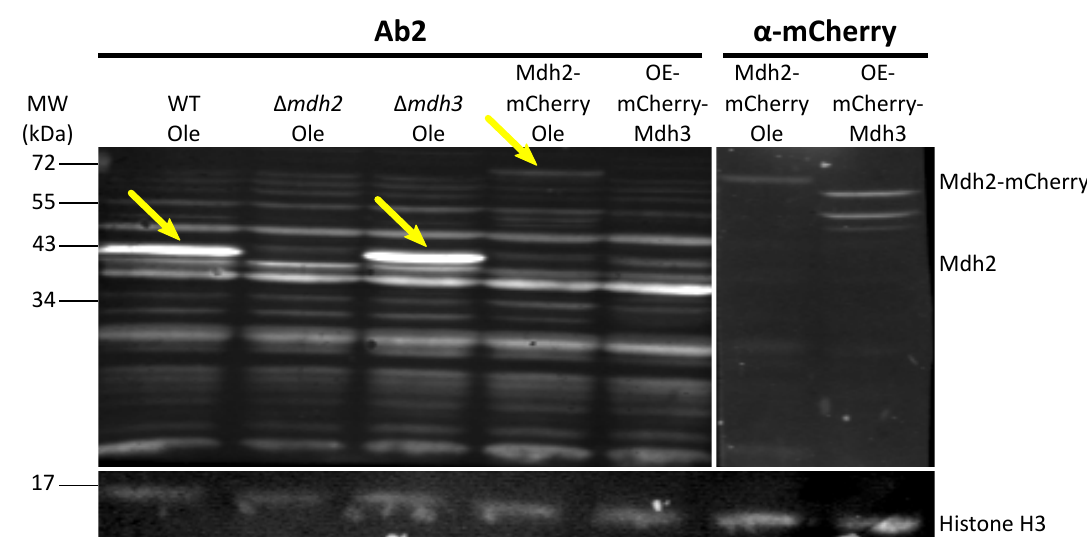
Figure 2. Antibody 2 displays isoform specificity. Western blot analysis was performed on protein extractions from different strains grown on oleic acid (Ole) or in glucose (only for OE-mCherry-Mdh3) using antibody 2 and anti-mCherry antibody. Antibody 2 recognizes the native Mdh2 in control cells and in Δ mdh3 cells grown in oleic acid, but does not recognize it in Δ mdh2 strain (second lane). The antibody also recognizes Mdh2 tagged with mCherry ( ∼ 70 kDa), but not the over-expressed and mCherry tagged Mdh3. The last one can be